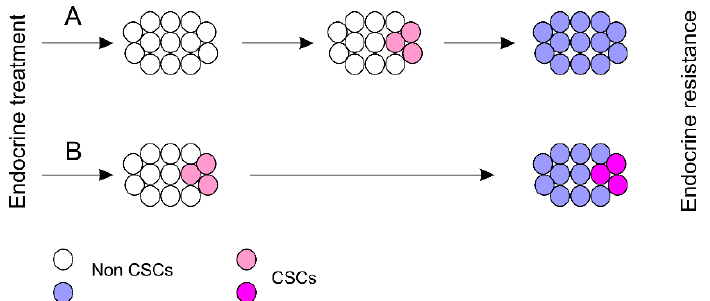
Figure 6. Models of BCSC regulation during ETR acquisition. ( A ) Endocrine treatment results in the acquisition of BCSCs through dedifferentiation (meddle cell population) which then produce tumors resistant to endocrine therapy (right cell population). ( B ) Endocrine therapy induces the pre-existing BCSCs to generate resistant BCs containing a fraction of BCSCs.